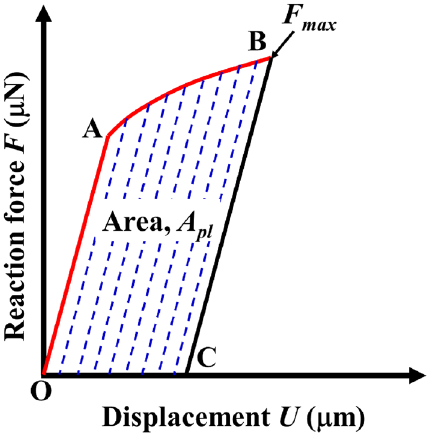
Figure 24. Schematic diagram of plastic work measurement.